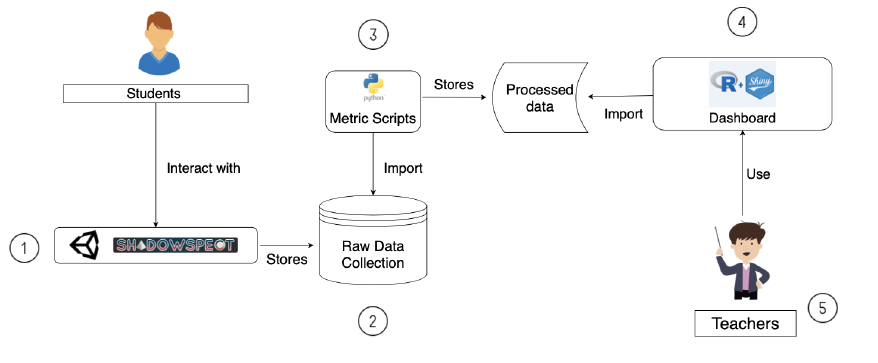
Figure 1. System’s general overview